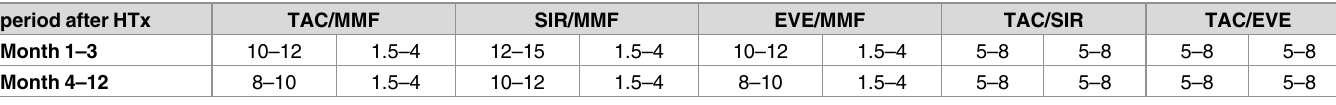
Table 1. Immunosuppression combinations and target levels. period after HTx